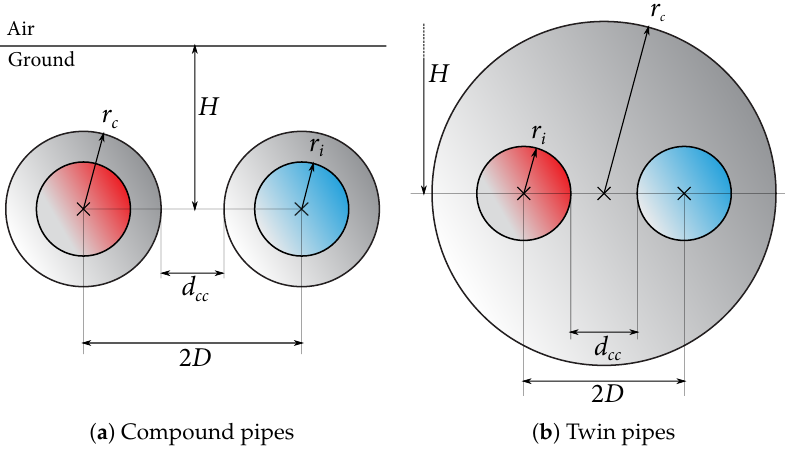
Figure A3. Schematic representation of the types of double pipes considered in this study with clarification of the dimensions used to calculate the thermal resistance of compound and twin pipes. The grey shaded area indicates insulation material, the red and blue shaded areas represent the water in the supply and return pipes,